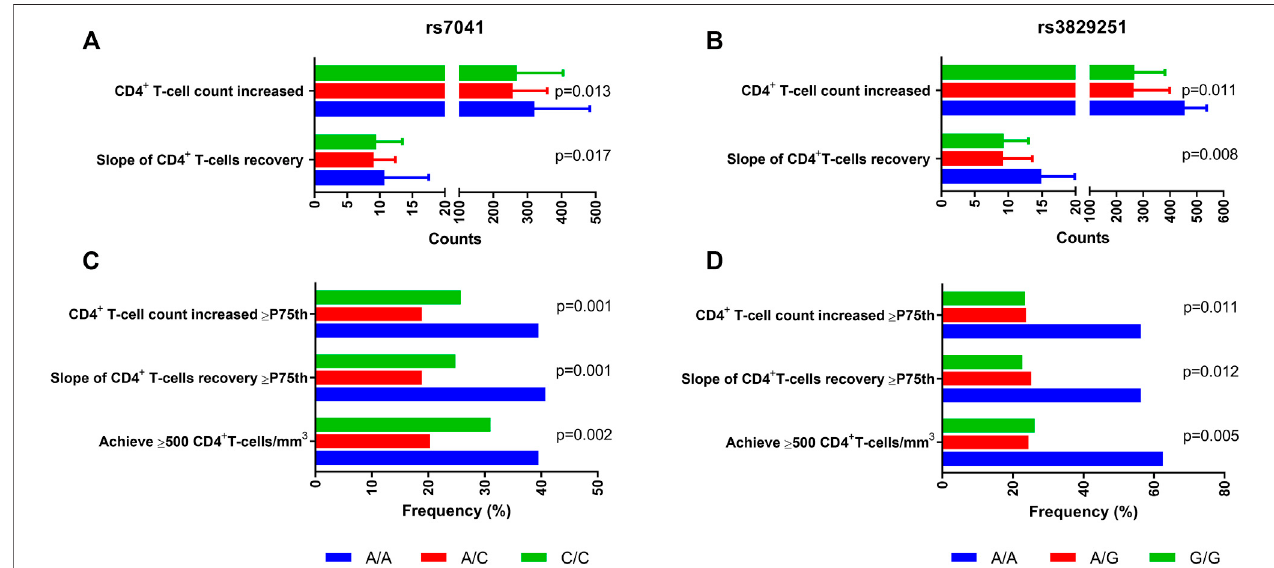
FIGURE 2 | Summary of outcome variables of CD4 + recovery in HIV-infected patients who started ART with very low CD4 + T-cells count ( < 200 cells/mm 3 ) accordingto DBP rs7041and DHCR7 rs3829251polymorphisms.Statistics:Valueswereexpressedaspercentagesandmedian(percentile25;percentile75).P-values were calculated by Chi-square and Kruskal-Wallis Tests.; Abbreviations: DBP, vitamin D binding protein; DHCR7, 7-Dehidrocolesterol reductase; HIV, human immunode fi ciency virus.